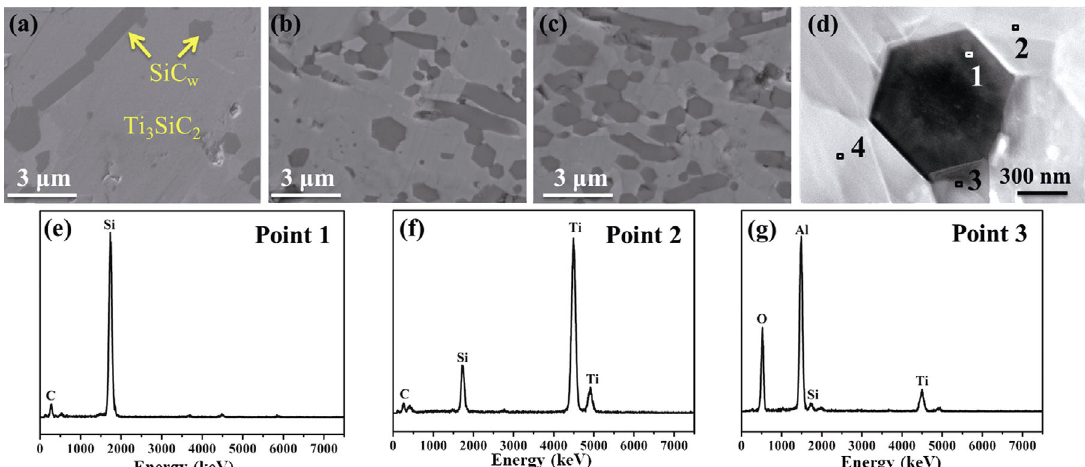
Fig. 5 SEM images for the polished surface of (a) 1 wt%, (b) 5 wt%, and (c) 10 wt% SiC w /Ti 3 SiC 2 . (d) HAADF image for the 10 wt% SiC w /Ti 3 SiC 2 and (e–g) EDS results for the points marked in (d).